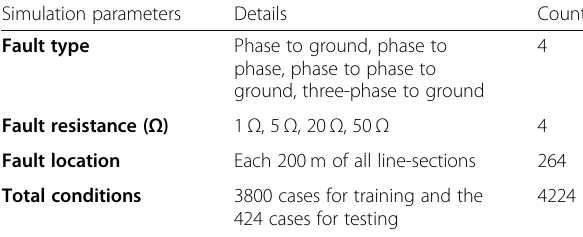
Table 2 Training/testing data